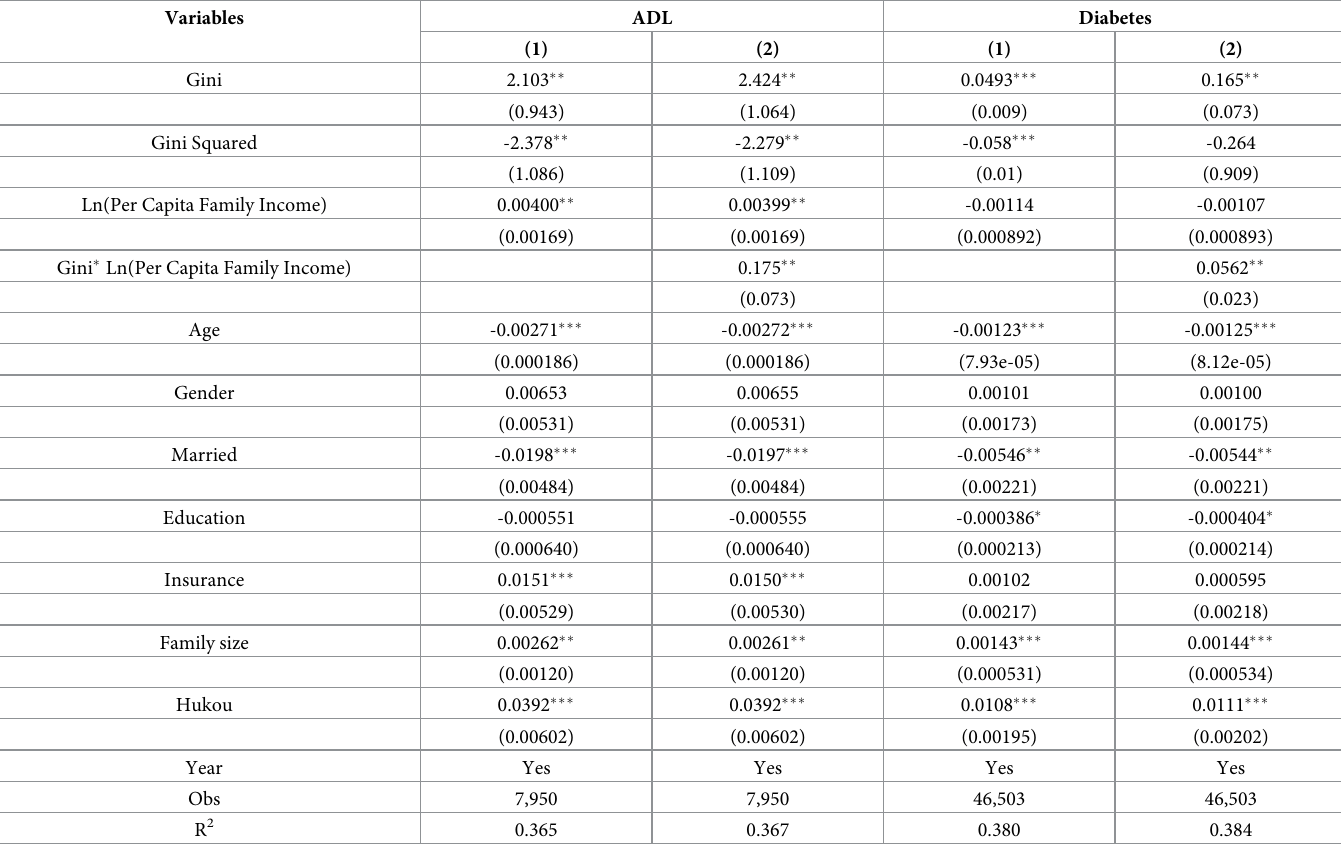
Table 6. The effects of Gini coefficient on ADL and